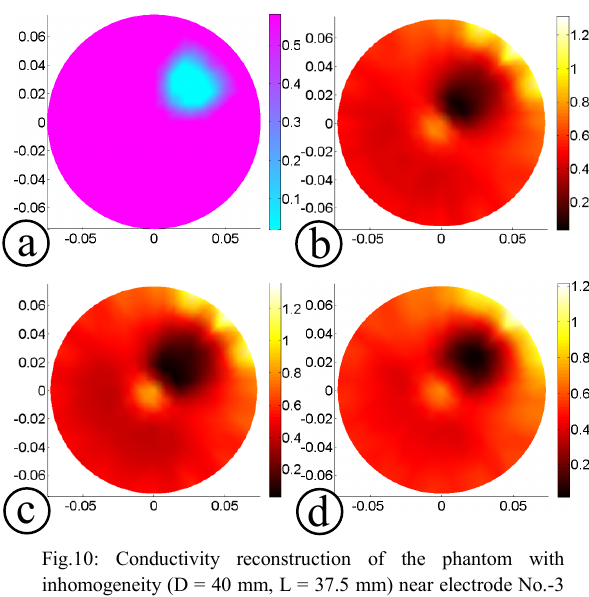
Fig .8: Conductivity reconstruction of the phantom with inhomogeneity (D = 20 mm, L = 37.5 mm) near electrode No.-3 ( λ = 0.0001 ): (a) original object, (b) image with STR, (c) image with LMR, (d) image with BMMR. Table-4: CNR, PCR and COC of the conductivity images of Fig. -8 20 mm Dia.